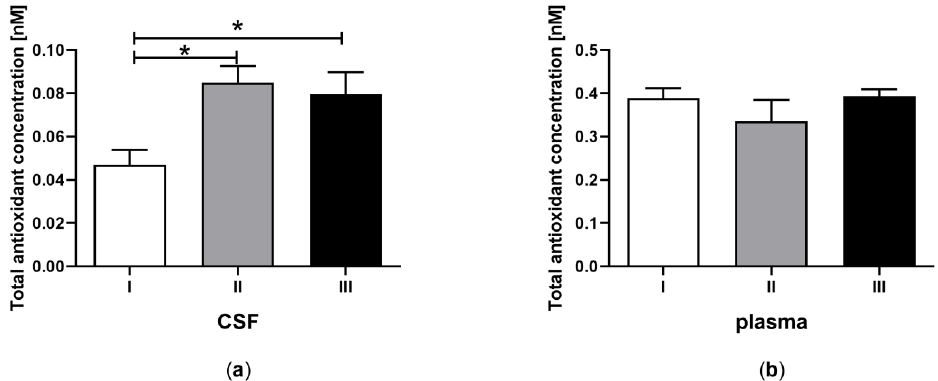
Figure 1. Total antioxidant capacity in cerebrospinal fluid (CSF) (Figure 1a) and plasma (Figure 1b) of the patients in MCS before (white bars) and after first (grey bars) and second (black bars) transplantation of bone marrow-derived (BM)-MSC. The statistical analysis was determined by a one-way ANOVA followed by Tukey’s multiple comparison test ( p < 0.05 ). Asterisks indicate differences in the antioxidant capacity between examining groups (* p < 0.05). Table 2. Total antioxidant capacity (A), ascorbic concentration (B), total ascorbate concentration (C), super oxide dismutase (D), and catalase (E) activity in CSF and plasma in patients in MCS before and after BM-MSC therapy. Small letters a and b indicate statistical differences in the measured parameters between CSF and plasma within the control, first, and second transplantation of BM-MSC. The statistical analysis was determined by Student’s t-test ( p < 0.0001). Before Treatment